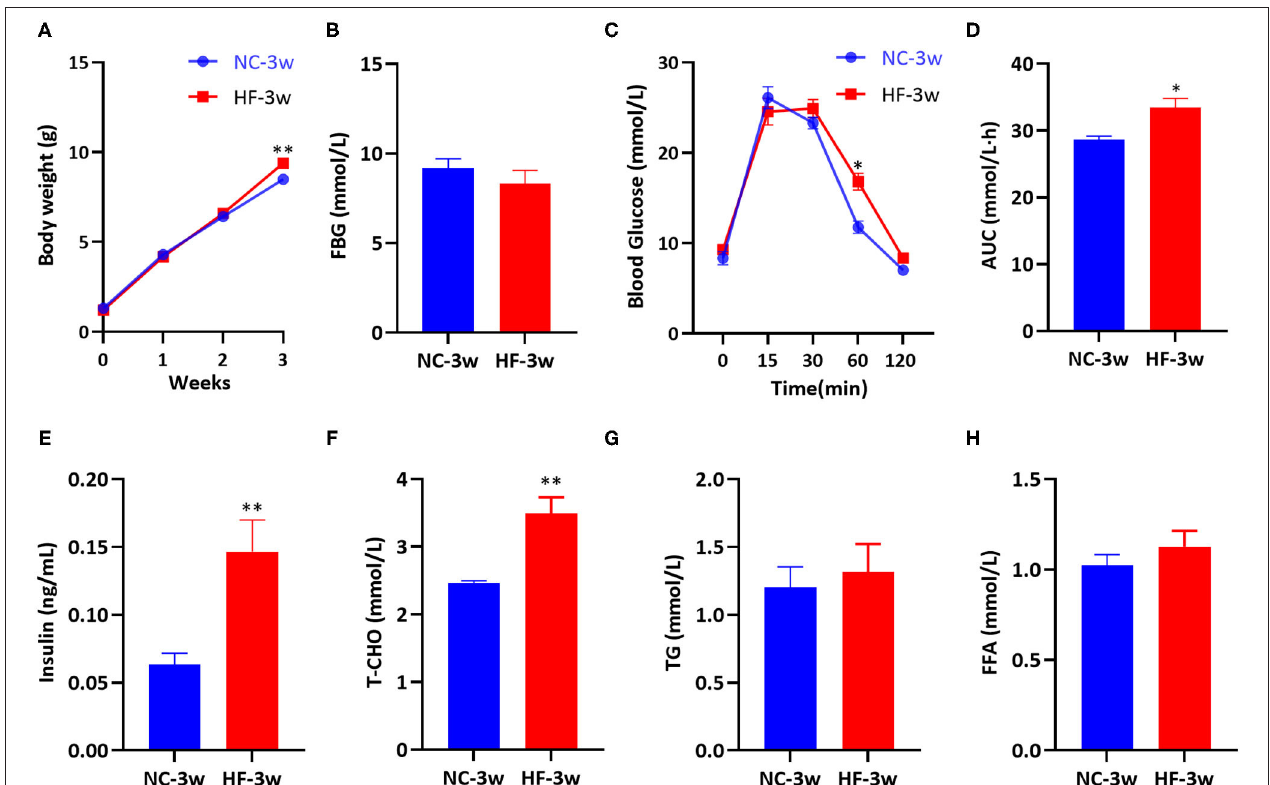
FIGURE 6 | Maternal HF feeding impaired glucose and lipid metabolism of offspring at weaning. (A) Body weight of male offspring from birth to weaning; (B) FBG of male offspring at weaning; (C) IPGTT and (D) AUC of male offspring at weaning; (E) Serum insulin; (F) Serum T-CHO; (G) Serum TG; (H) Serum FFA of male offspring at weaning. Data represented as the mean ± SEM. (NC-3w, n = 8; HF-3w, n = 6–8). * p < 0.05, ** p < 0.01 vs. NC-3w. NC, normal chow diet; HF, high-fat diet; 3w, the third week; FBG, fasting blood glucose; IPGTT, intraperitoneal glucose tolerance test; AUC, the area under the glucose curve; T-CHO, total cholesterol; TG, triglyceride; FFA, free fatty